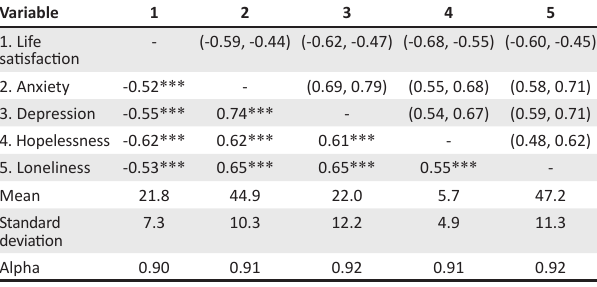
TABLE 1: Intercorrelations, reliabilities and descriptive statistics for variables. Variable 1